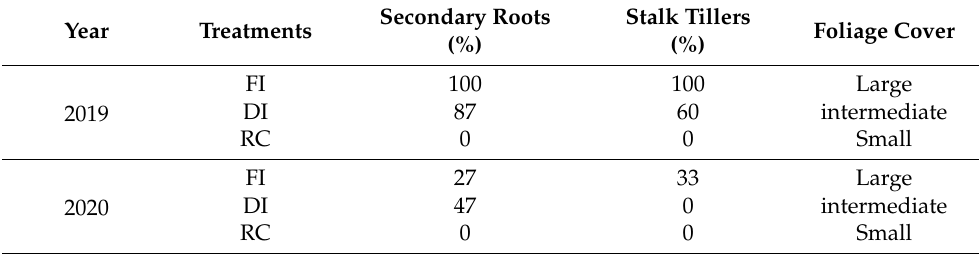
Table 2. Morphological traits measured at harvesting. Values are expressed as percentage over the total plants per